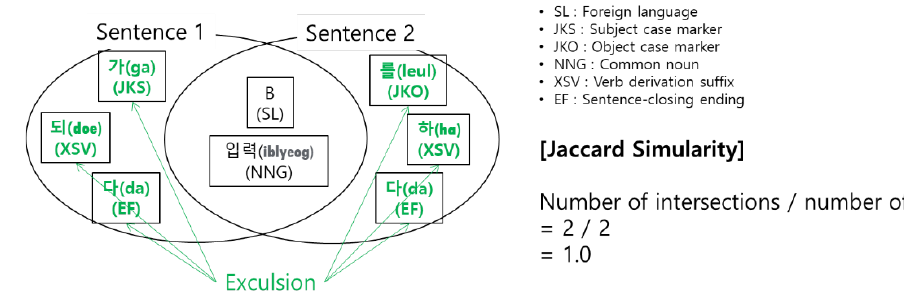
Figure 10. Union and intersection of morphemes.